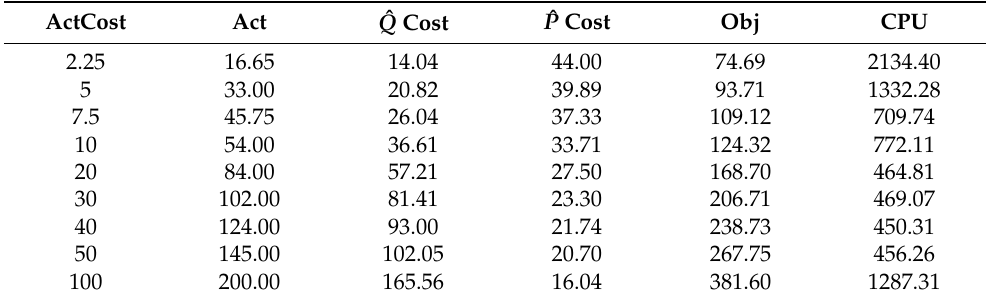
Table 12. Cost components of the objective function as the cost of activating pds